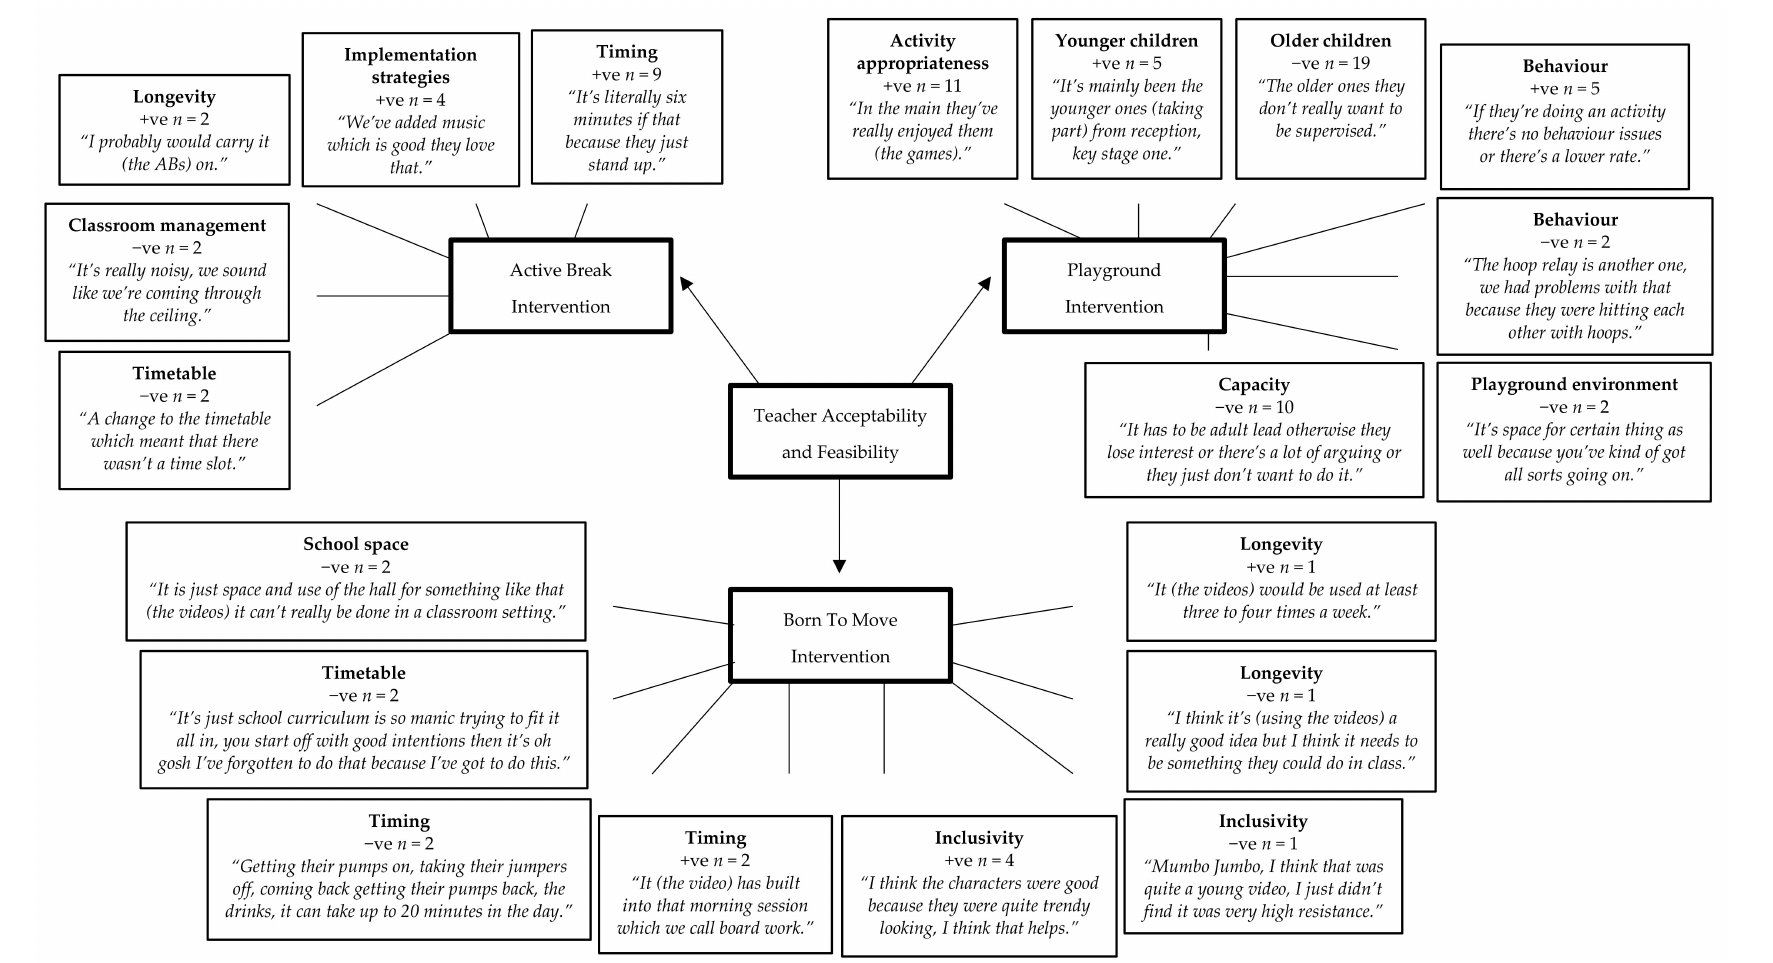
Figure 2. Teacher acceptability and feasibility of each intervention. +ve = positive. − ve =